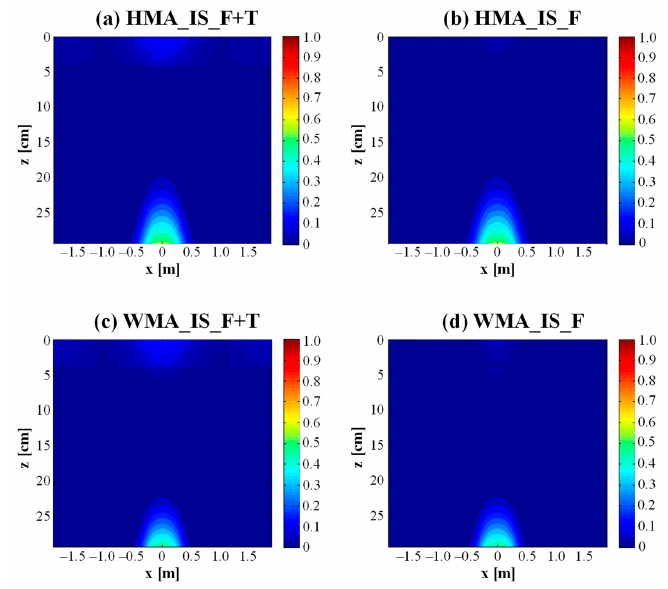
Figure 7. Damage contours in the case of intact subbase after 30 years.